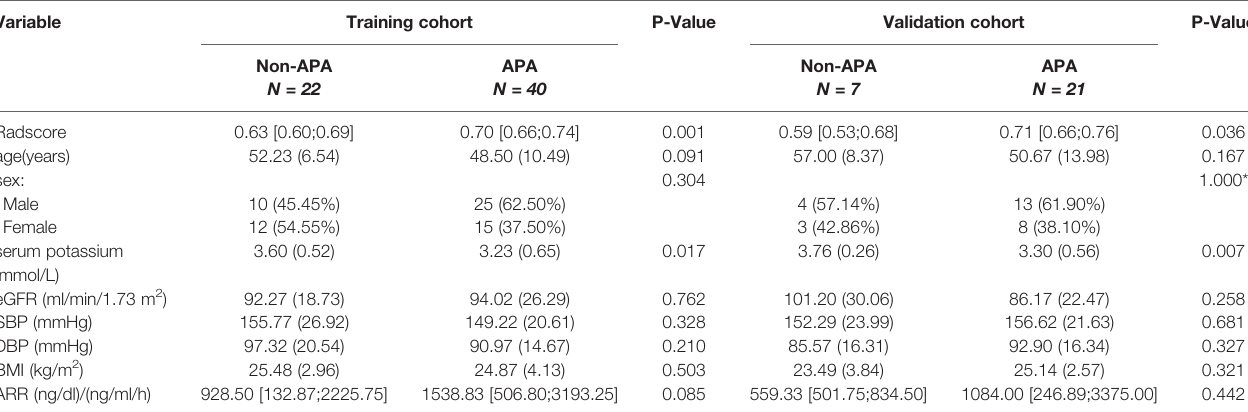
TABLE 2 | Clinical characteristics of APA-positive and APA-negative patients in the training and validation cohorts.